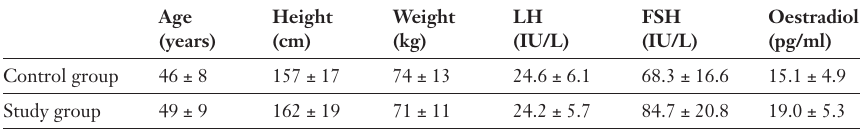
The levels of mea- sured parameters of both control and study group before and after HRT treat- ment. (Abbreviations; HDL: High-density lipoprotein, TAC: Total antioxidant ca- pacity, HRT: Hormone replacement ther-